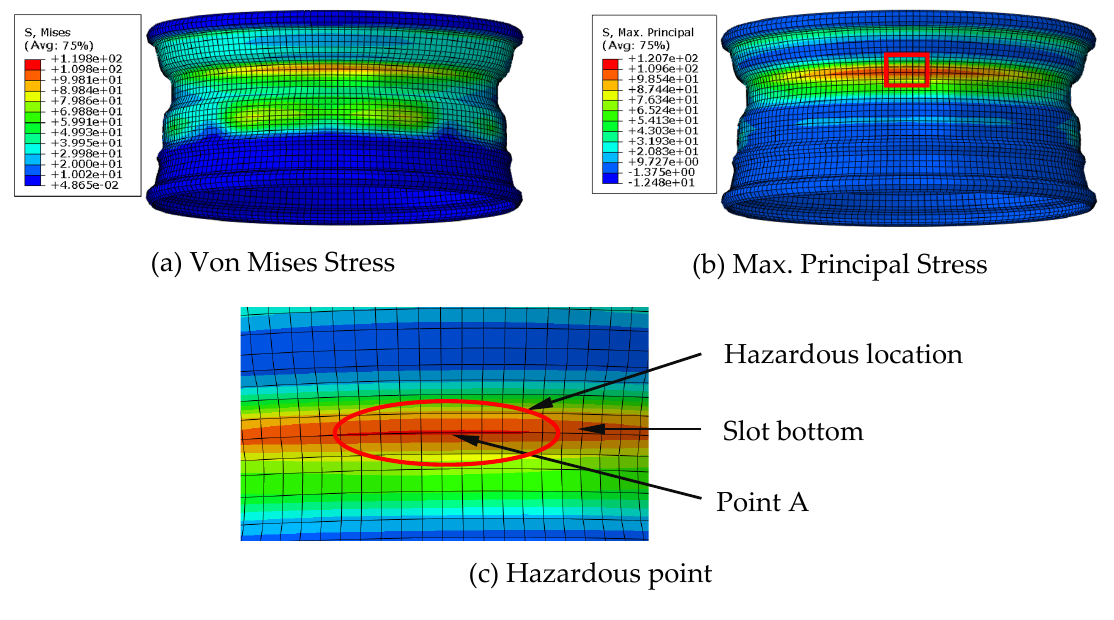
Figure 12. Stress results at hazard points.